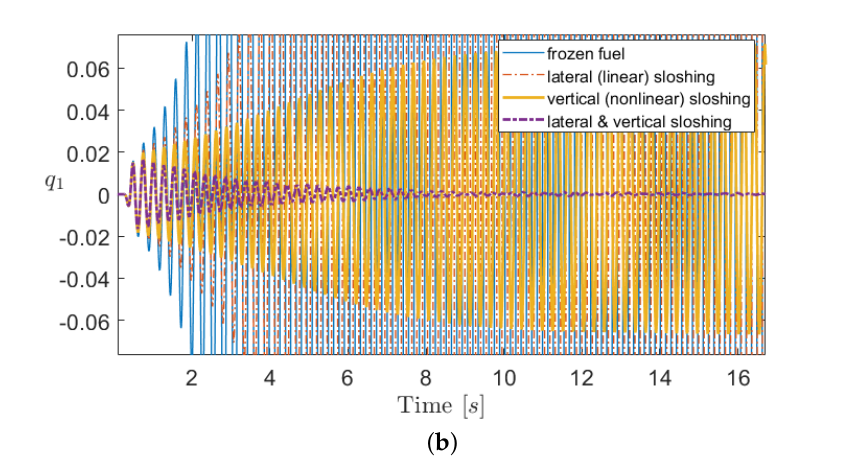
= 0.2m/s—Test Case 2. ( a ) Local angle of attack. ( b ) First a